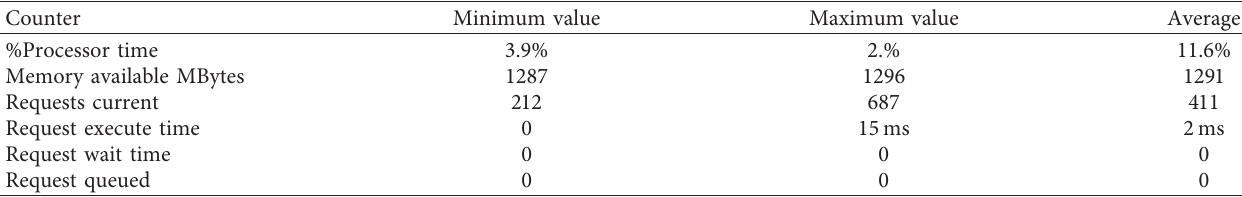
Table 3: Main performance specifications and detection values of the server.